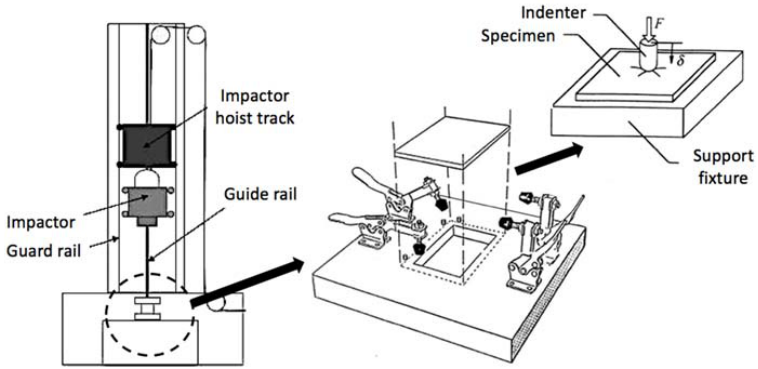
Figure 4. Drop ‐ weight impact tower scheme. Figure 4. Drop-weight impact tower